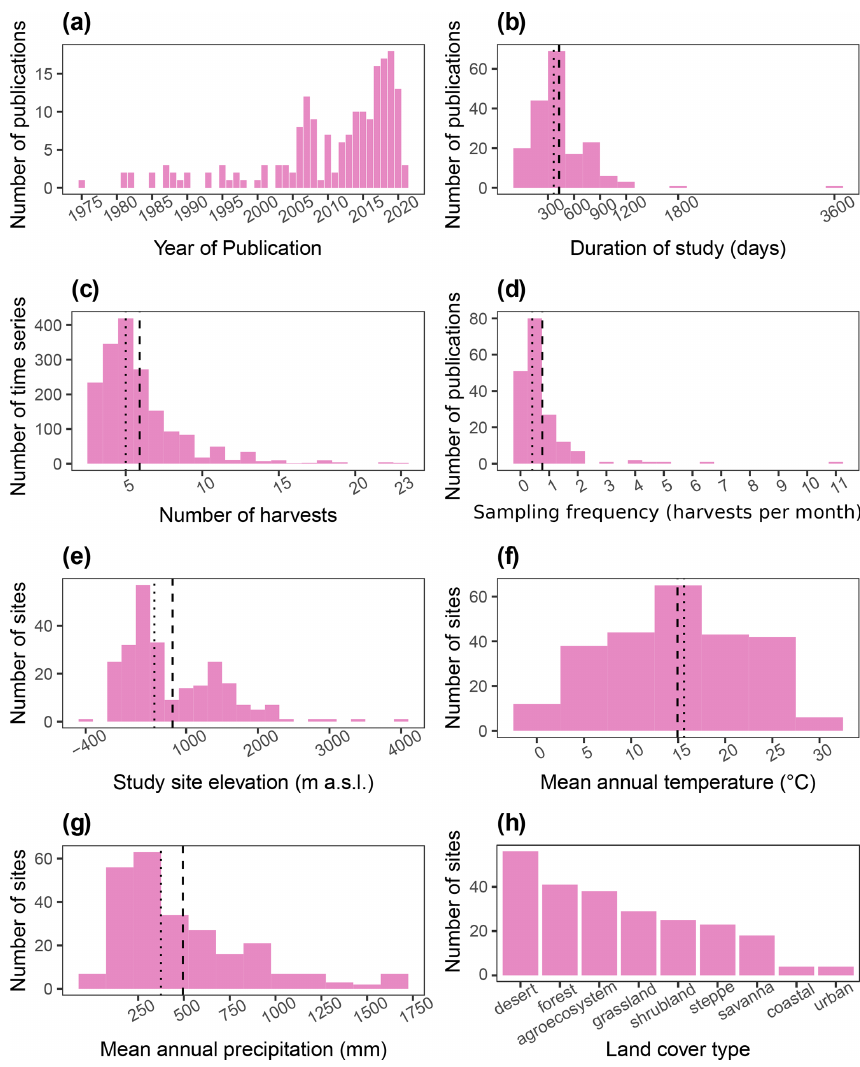
Figure 4. Aridec data overview including number of publications per year (a) , study duration in days (b) , number of sample harvests (c) , study sampling frequency as number of samplings per month (d) , study site altitude in ma.s.l. (e) , mean annual temperature in ◦ C (f) , mean annual precipitation in mm (g) , and number of studies per type of land cover (h) . Dashed lines represent the mean, and dotted lines represent the median in each